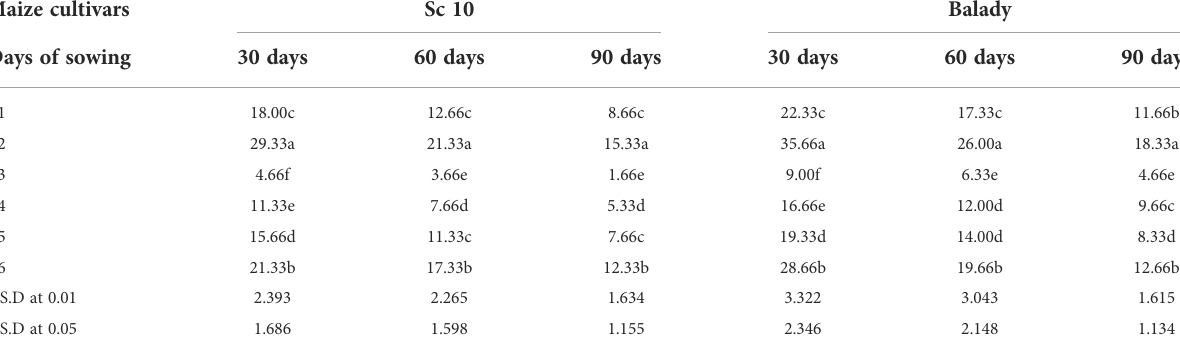
TABLE 4 Fusarium verticillioides frequency % from roots under different soil treatments at different times after sowing during the 2020 growing season. Maize cultivars Sc 10 Balady